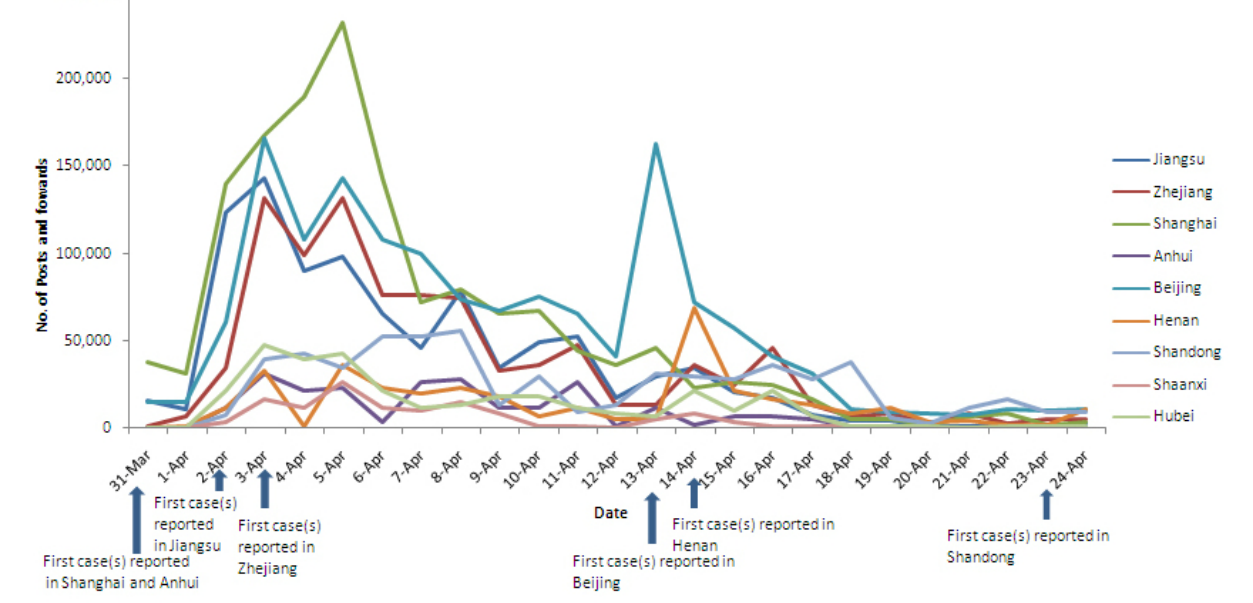
Figure 4. The daily posted and forwarded number for H7N9 on Sina microblog by province/city from March 31 to April 24,